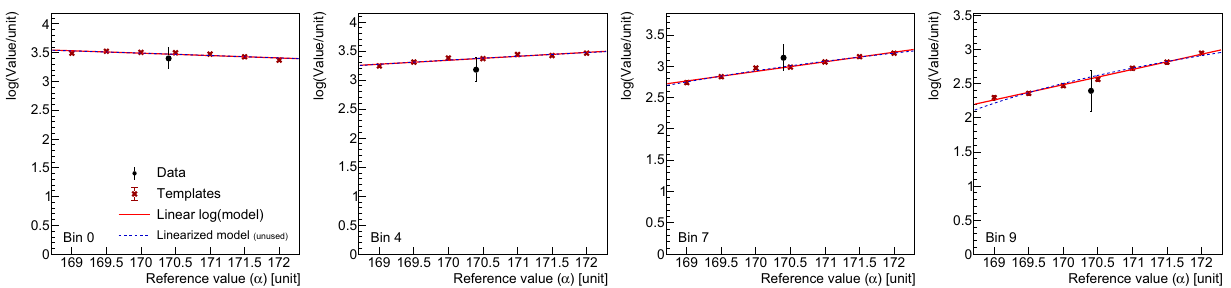
Fig. 4 The best estimate of the parameter dependence of the model, Eq. (38) for four selected bins of Example 1, when performing a Lin- ear Template Fit with log-normally distributed estimators. Note that the y -axis indicates the logarithmized values of the templates. The pseudo-